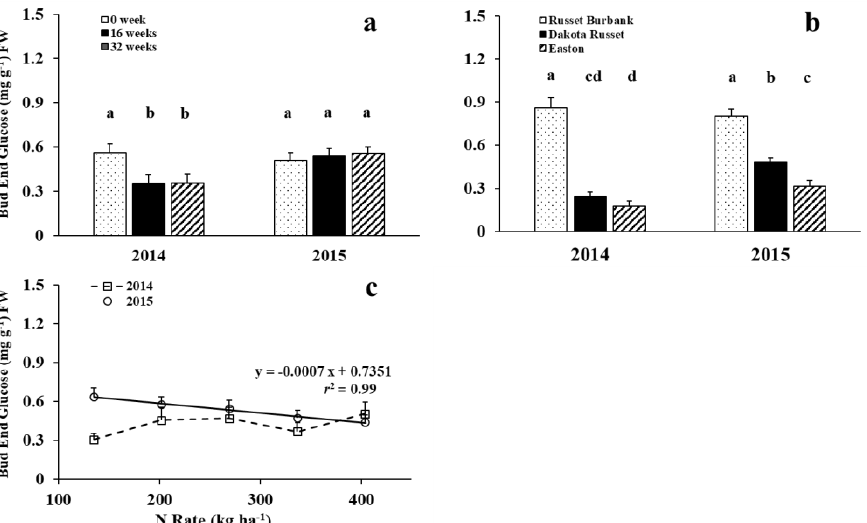
Figure 3. Interactions of storage by year (a), cultivar by year (b), and N rate by year (c) effects on bud-end glucose (Means were separated at the 5% level, with the same letter above the bar indicating no significant difference.).